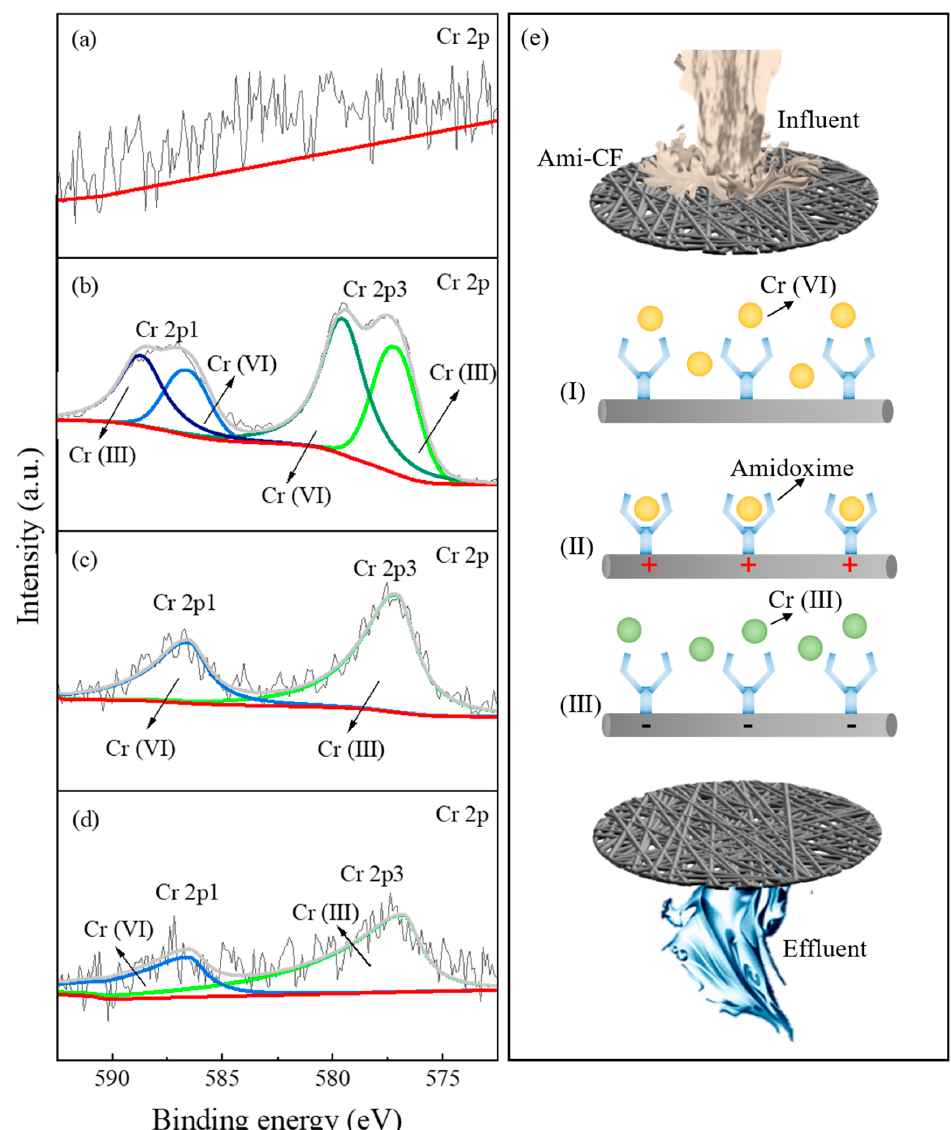
Figure 7. ( a ) before and ( b ) after the Cr( Ⅵ ) adsorbed on Ami ‐ CF, ( c ) DC and ( d ) AC method on Ami ‐ CF, and ( e ) reduction process of Cr ( Ⅵ ) mediated by AC.